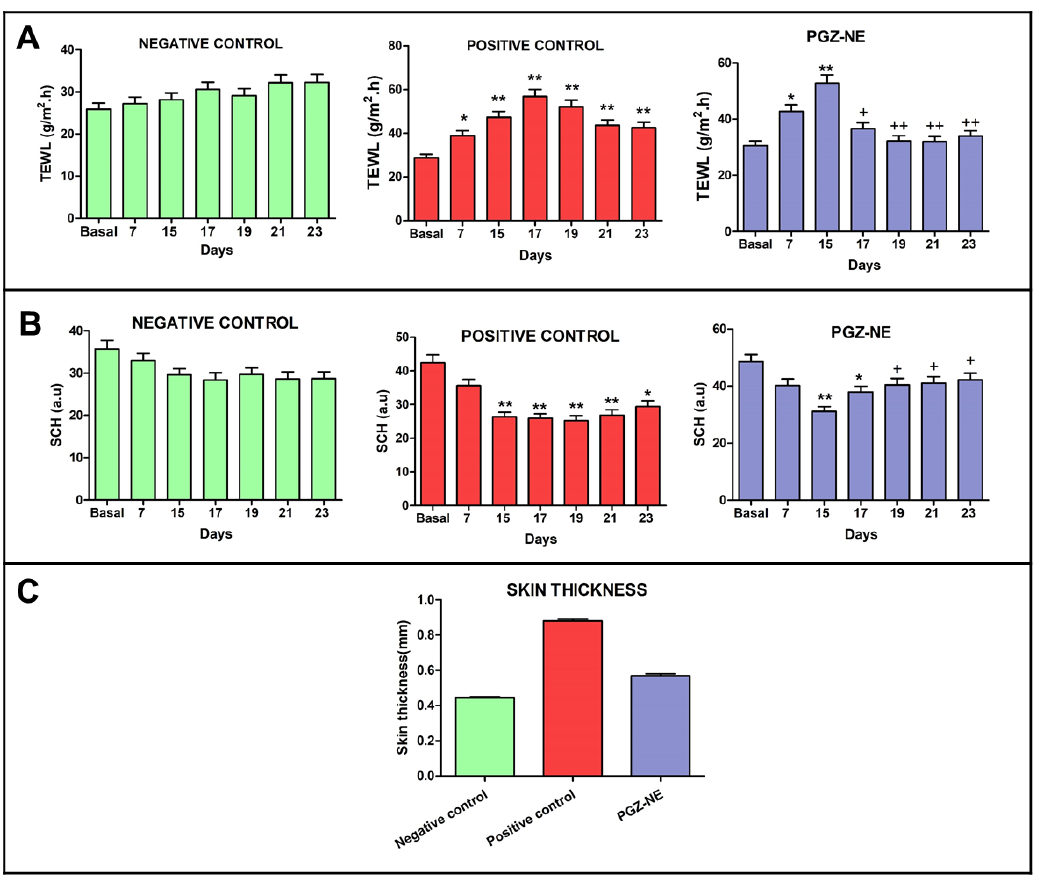
Figure 4. Evaluation of skin barrier function in each experimental group using oxazolone-induced atopic dermatitis model: ( A ) Transepidermal water loss (TEWL); ( B ) Stratum corneum hydration (SCH); and ( C ) skin thickness. Results are expressed as mean ± SD ( n = 3). Significant statistical di ff erences: * p < 0.05, ** p < 0.01 comparison with the basal state. + p < 0.05, ++ p < 0.01 comparison with Day 15 (first administration of PGZ-NE).